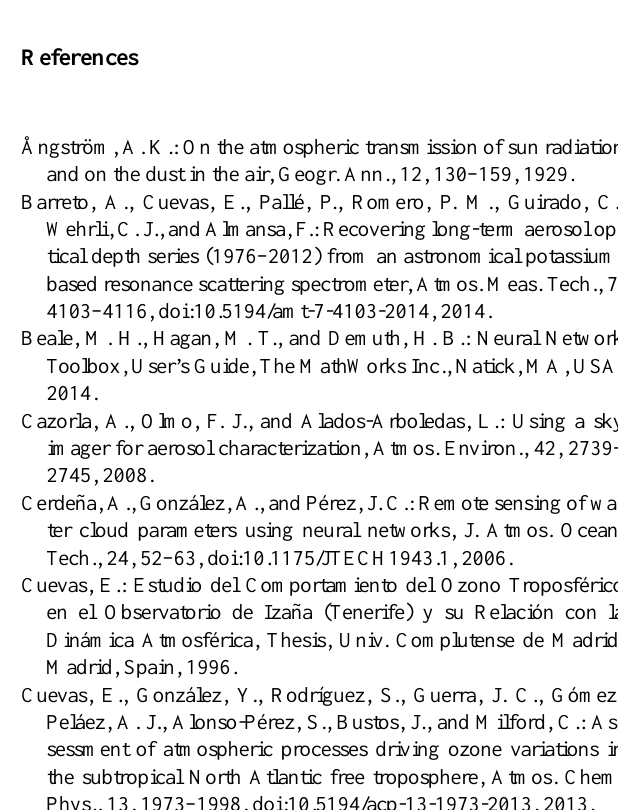
Figure 6. (a) Time series of the number of days grouped into ANN AOD intervals (AOD ≥ 0.05; AOD ≥ 0.10; AOD ≥ 0.20) on the left axis, while on the right axis, the bars indicate the number of days with SYNOP data reporting dust in suspension (05–06 SYNOP codes) for the period 1941–2009. The 5-year running mean is shown in black. (b) Scatterplot of number of days with ANN AOD ≥ 0.20 and number of days with 05–06 SYNOP codes. The least-square fit parameters are shown in the legend. (c) Time series of the ANN AOD monthly medians (blue line) and monthly percentage of time the wind blows from the second quadrant (E–S; 90–180 ◦ ) (black line) at IZO in July in the period 1941–2009. (d) Percentage of time ( y axis) the wind blows from in each one of the four quadrants vs. the ANN AOD monthly medians ( x axis). R indicates the Pearson